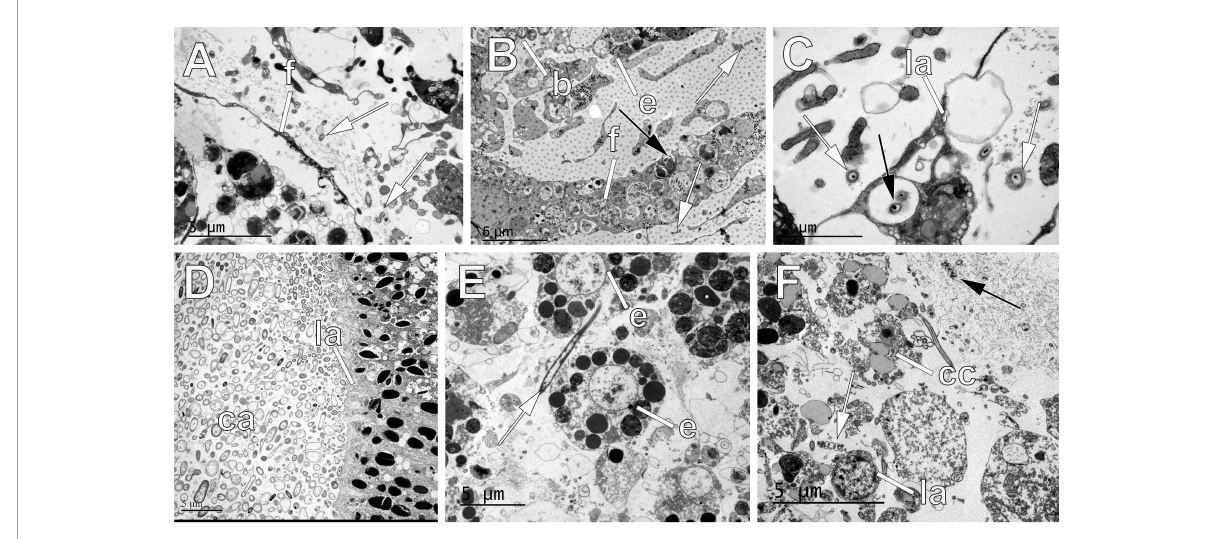
FIGURE6 Symbionts within embryos and larvae of sponges. (A) Symbiotic bacteria (white arrows) in the mesohyl of the haplosclerid Haliclona penicillata accumulating close to the embryonic follicle (f). (B) Symbionts (white arrows) outside and inside the embryonic follicle (f) of the poecilosclerid Kirkpatrickia variolosa . Note the follicle cell (f) forming yolk with the product of bacterial digestion (black arrow). Note the embryo containing large bacterial cells (b) different from the small symbionts (white arrows). (C) Larval cells (la) of the haplosclerid Hemigellius pilosus showing bacteria within the cells (black arrow) and between cells (white arrows). (D) Larval cavity (ca) of the cinctoblastula larva (la) of the homosclerophorid Corticium candelabrum showing large accumulations of symbiotic bacteria. (E) Embryonic cells (e) of the poecilosclerid Mycale laevis showing a large symbiotic bacterium (white arrow) between them. (F) Inner larval cells (la) and ciliated epithelial cells (cc) in the larva of the poecilosclerid M. laevis showing the presence of symbiotic spirochetes (white arrow) interspersed between them similar to the ones present in the mesohyl (black